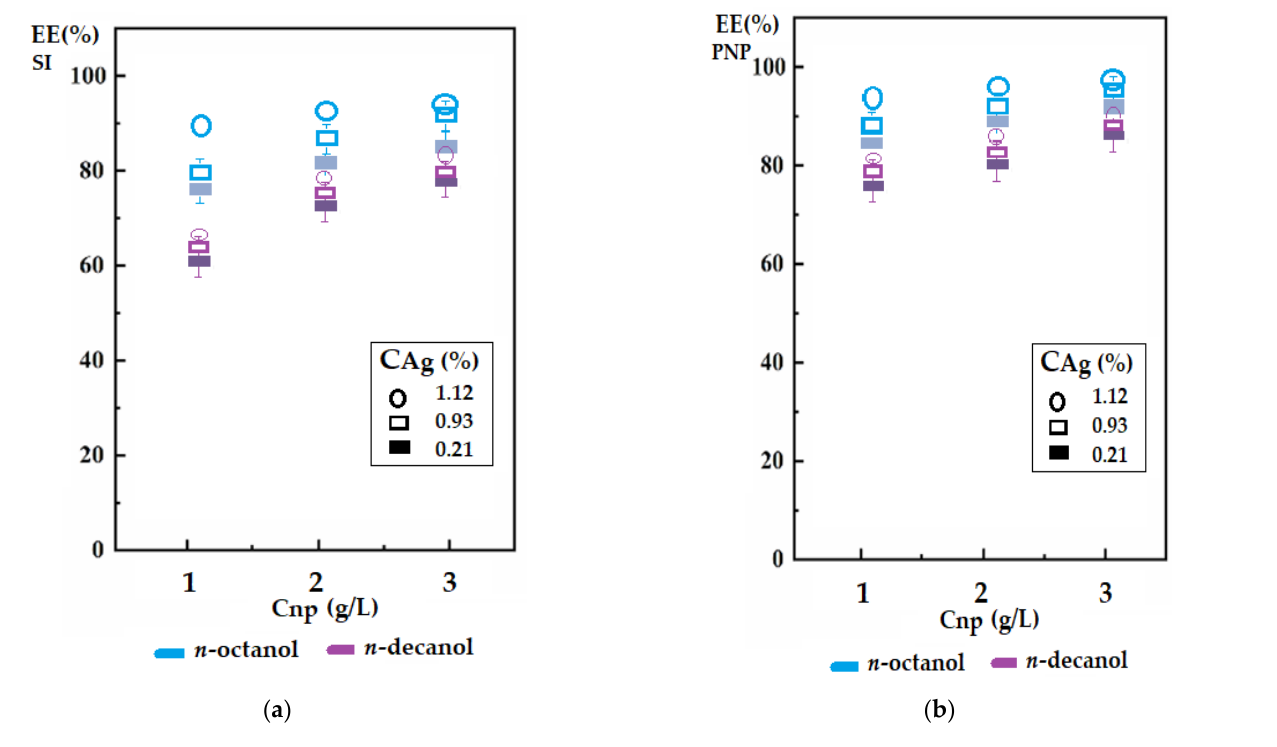
Figure 8. The efficiency of the separation of silver ions (SI) and p -nitrophenol (PNP) as a function of the concentration of magnetic nanoparticles (C np ) in the membrane solvent and their silver content (C Ag ): ( a ) SI extraction; ( b ) PNP extraction.